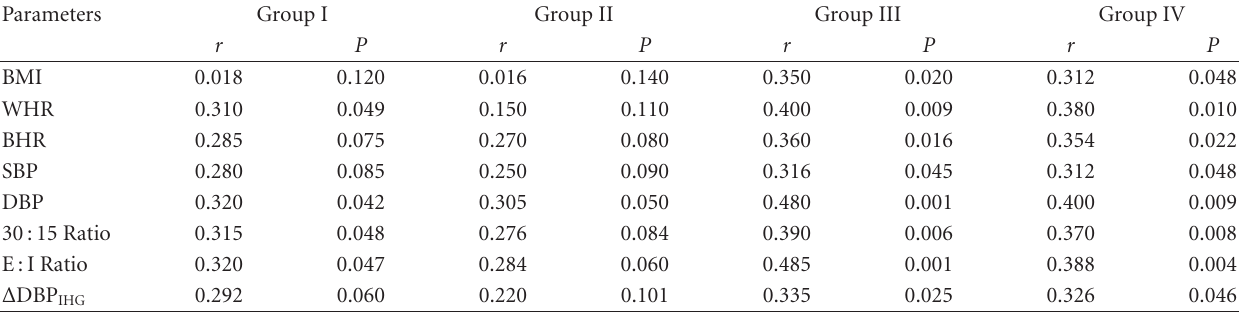
Table 5: Correlation of LF-HF ratio with BMI, WHR, BHR, blood pressure, 30: 15 ratio, E: I ratio, and Δ DBP IHG of various groups.